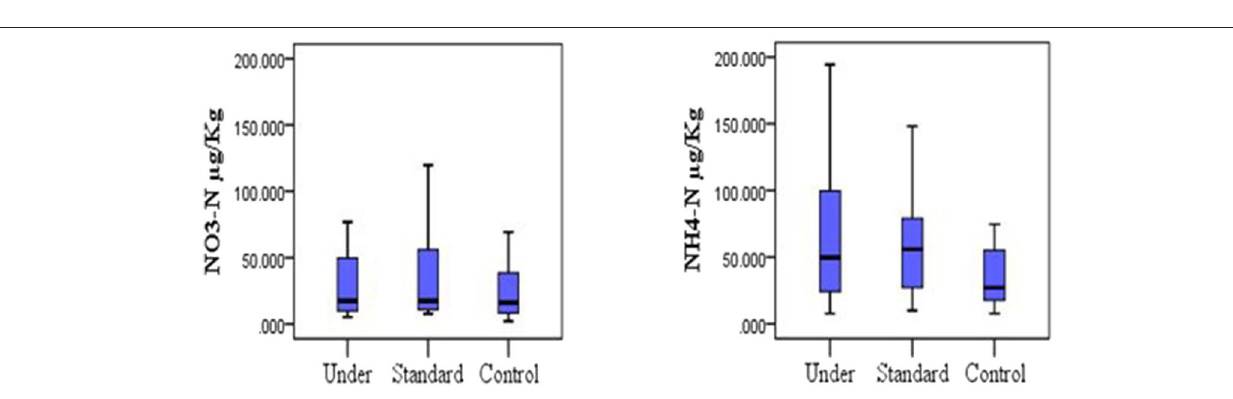
FIGURE 3 | Distribution of nitrogen species (nitrate and ammonium) under different fertilization scenarios in the soil, (Kruskal-Wallis test, P >